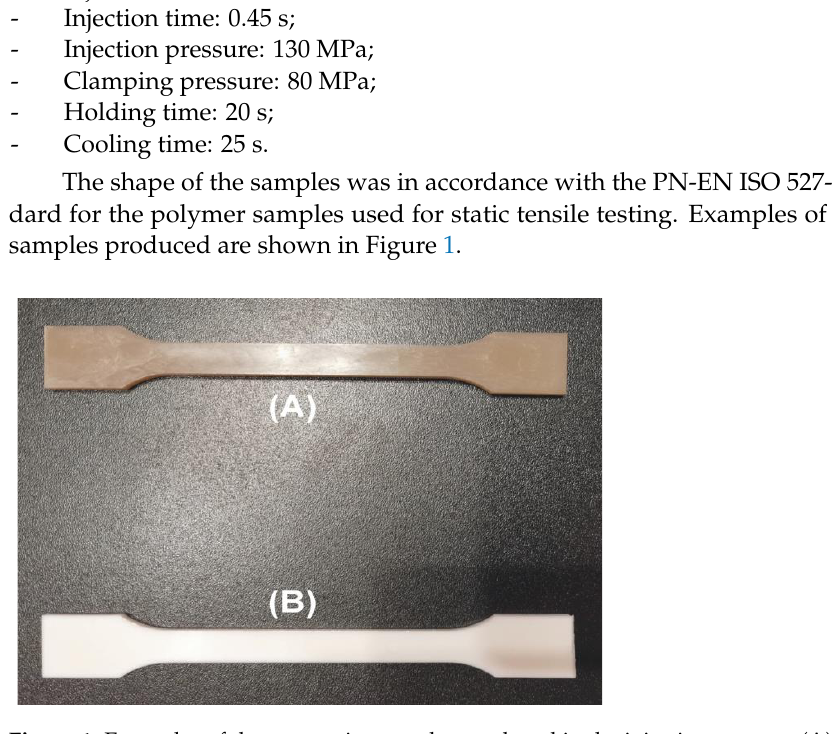
Figure 1. Examples of the composite samples produced in the injection process: ( A ) composite with HDPE matrix, ( B ) composite with PBT matrix.